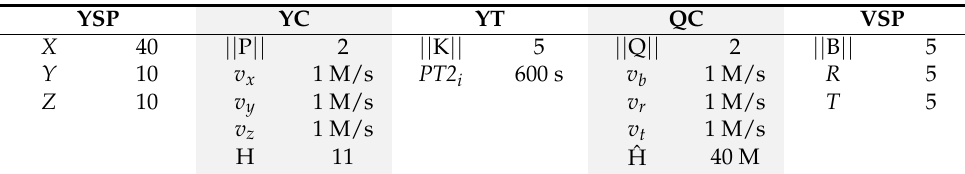
Table 2. The parameter setting for YC, YT and QC.